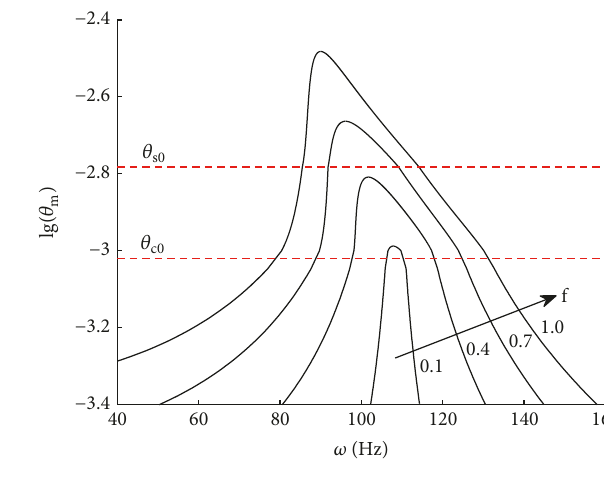
−3.5−3.4−3.3−3.2−3.1−3−2.9−2.8−2.7 Ｇ ( 𝜃 l g Figure 9: Effect of natural frequency. Figure 10: Effect of isolator space.